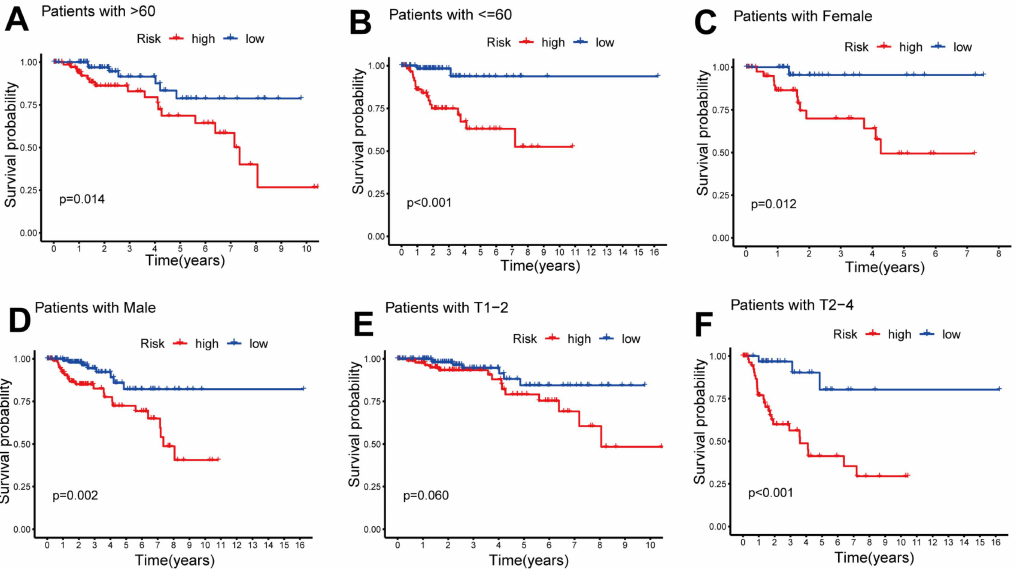
Figure 4. Kaplan–Meier (KM) survival analysis of low- and high-risk patients with different clinical covariates. Age ( A , B ), gender ( C , D ) and T stage ( E , F